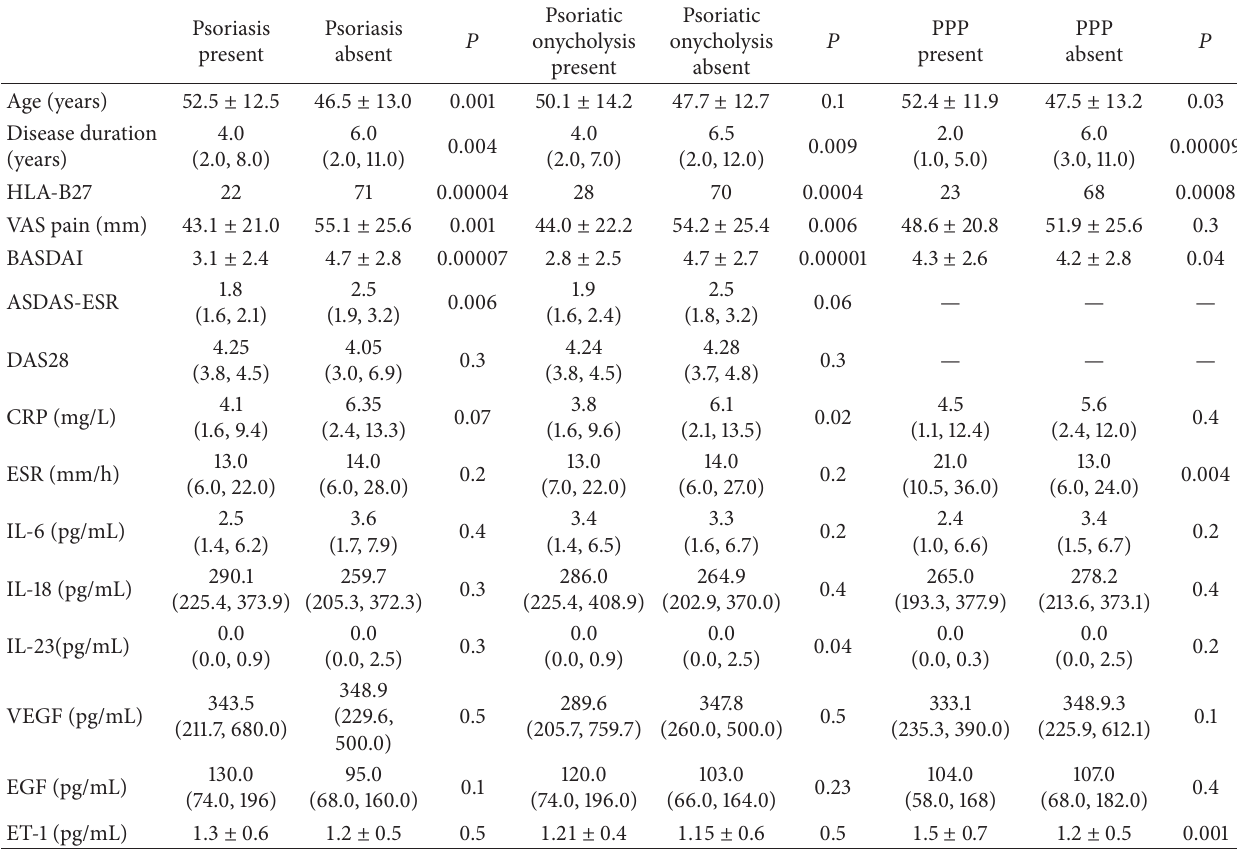
Table 3: Comparison of serum levels of selected cytokines and markers of disease activity in spondyloarthritis patients with and without skin psoriasis, psoriatic onycholysis, and palmoplantar pustulosis.